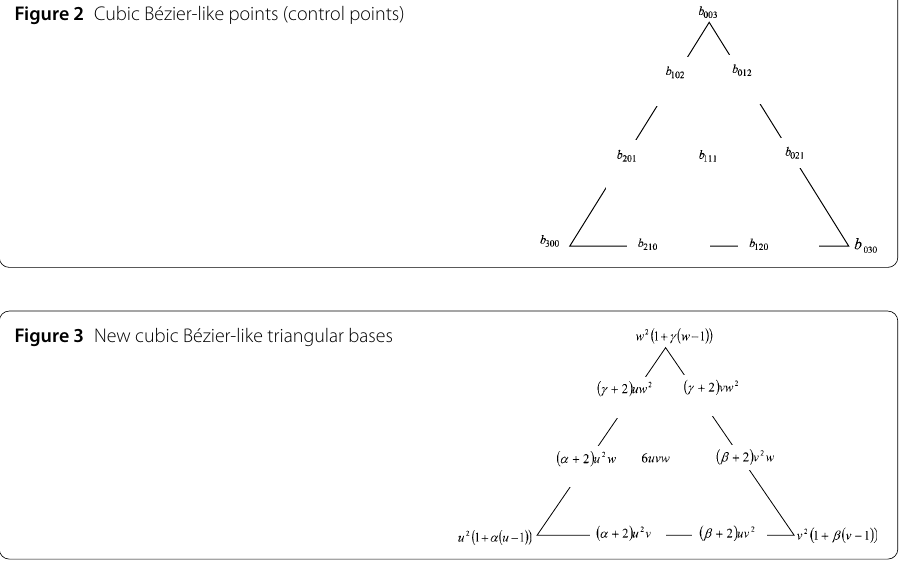
Figure 2 Cubic Bézier-like points (control points)